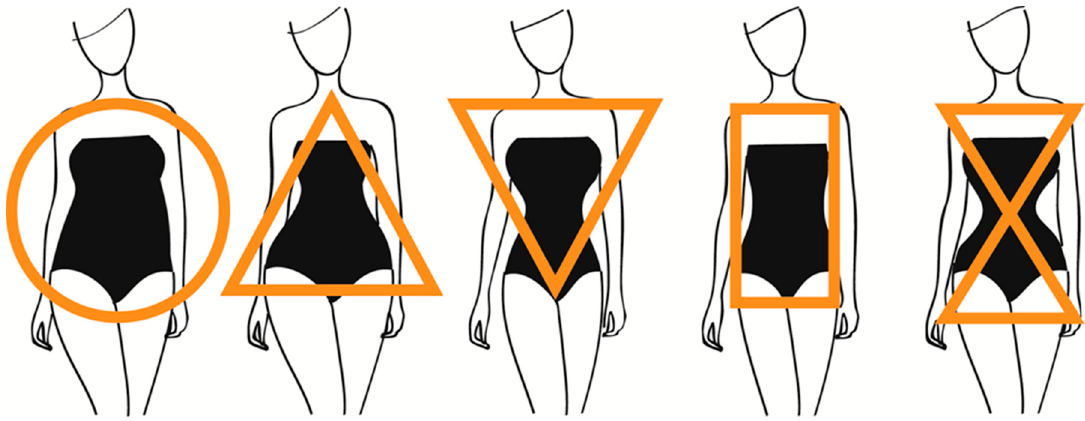
Figure A4. Ideal Body Shape.